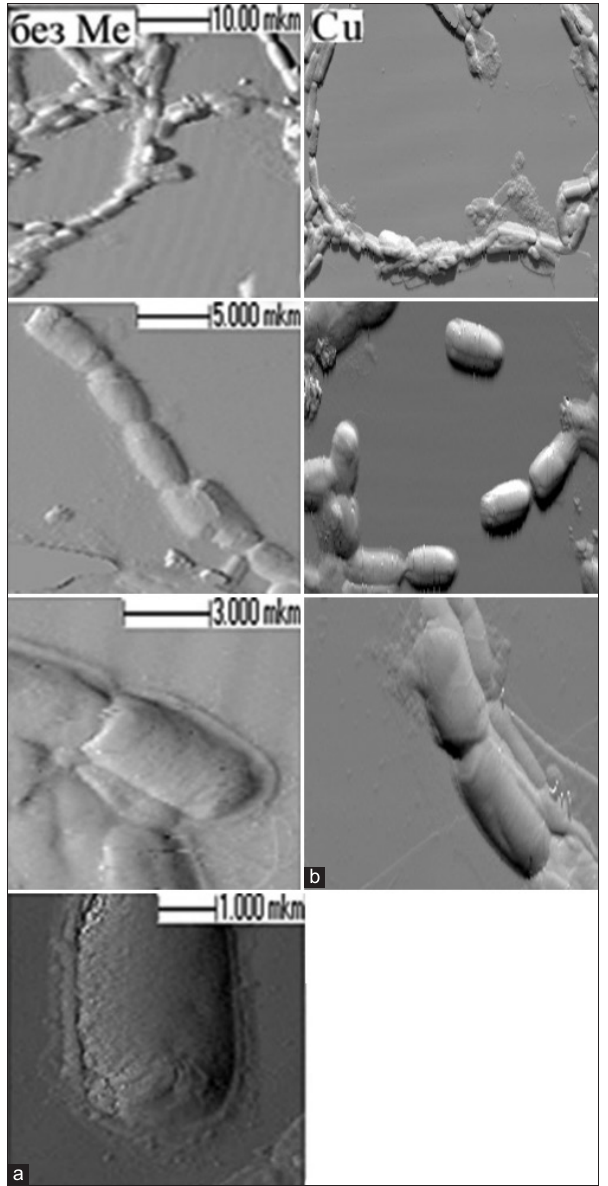
Figure-3: Images of Bacillus licheniformis 7038 bacteria derived using atomic-force microscopy: (a) No metals; (b) in the presence of copper